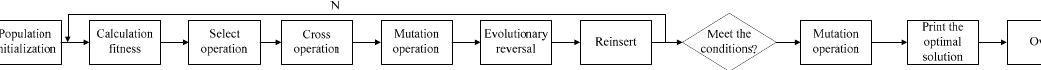
Figure 3. Implementation process method. 4. Case Study